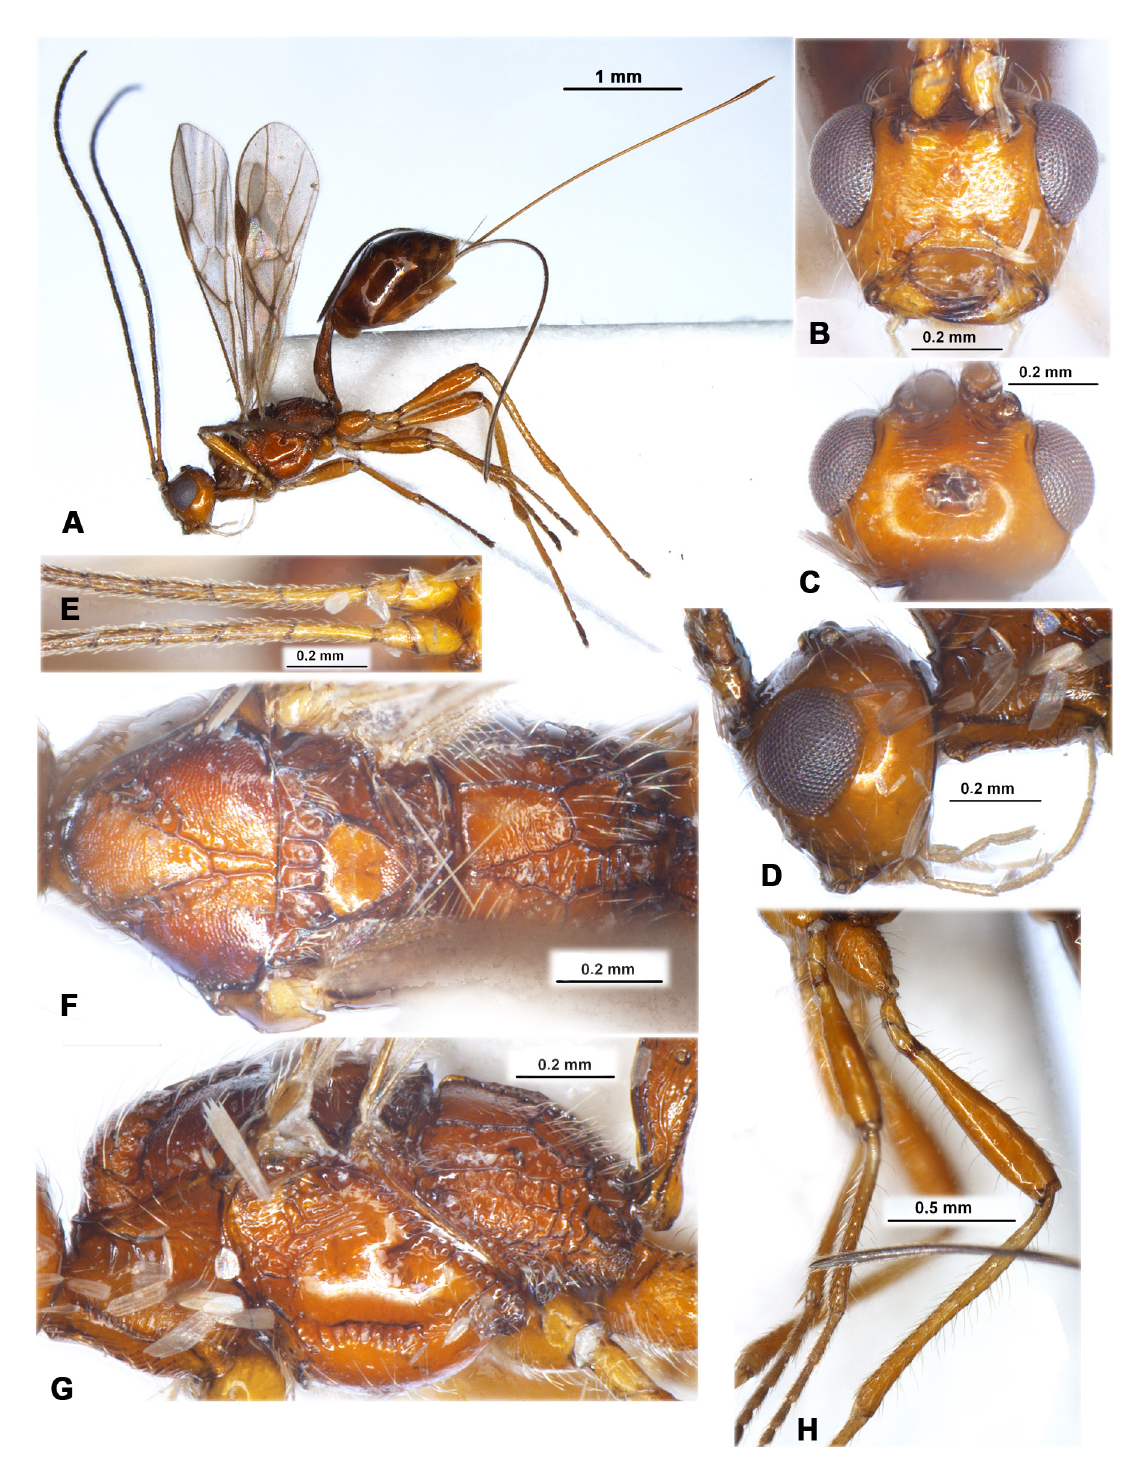
Fig. 22. Spathius nixoni Belokobylskij & Maetô, 2009, ♀ (RMNH). A . Habitus, lateral view. B . Head, front view. C . Head, dorsal view. D . Head, lateral view. E . Basal segments of antenna. F . Mesosoma, dorsal view. G . Mesosoma, lateral view. H . Hind